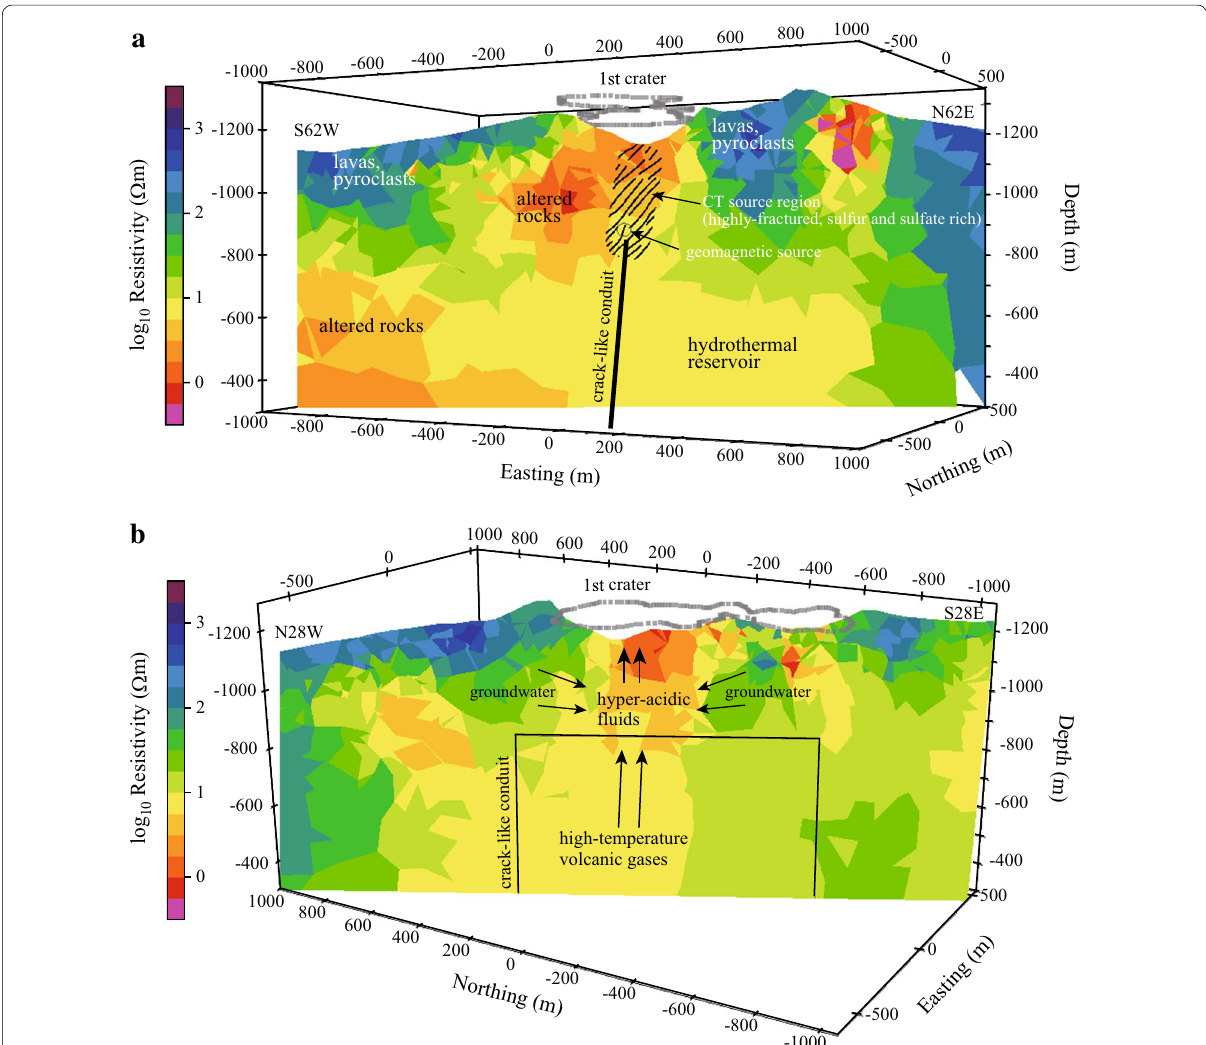
Fig. 5 Interpretation of the 3-D resistivity model. a Vertical section through the first crater perpendicular to the strike of the crack-like conduit (Yamamoto et al. 1999). The CT source region and the geomagnetic source are drawn based on Ichimura et al. (2018) and Tanaka (1993), respectively. b Sub-vertical section along the surface of the crack-like conduit. Flows of interpreted hydrothermal fluids are indicated by